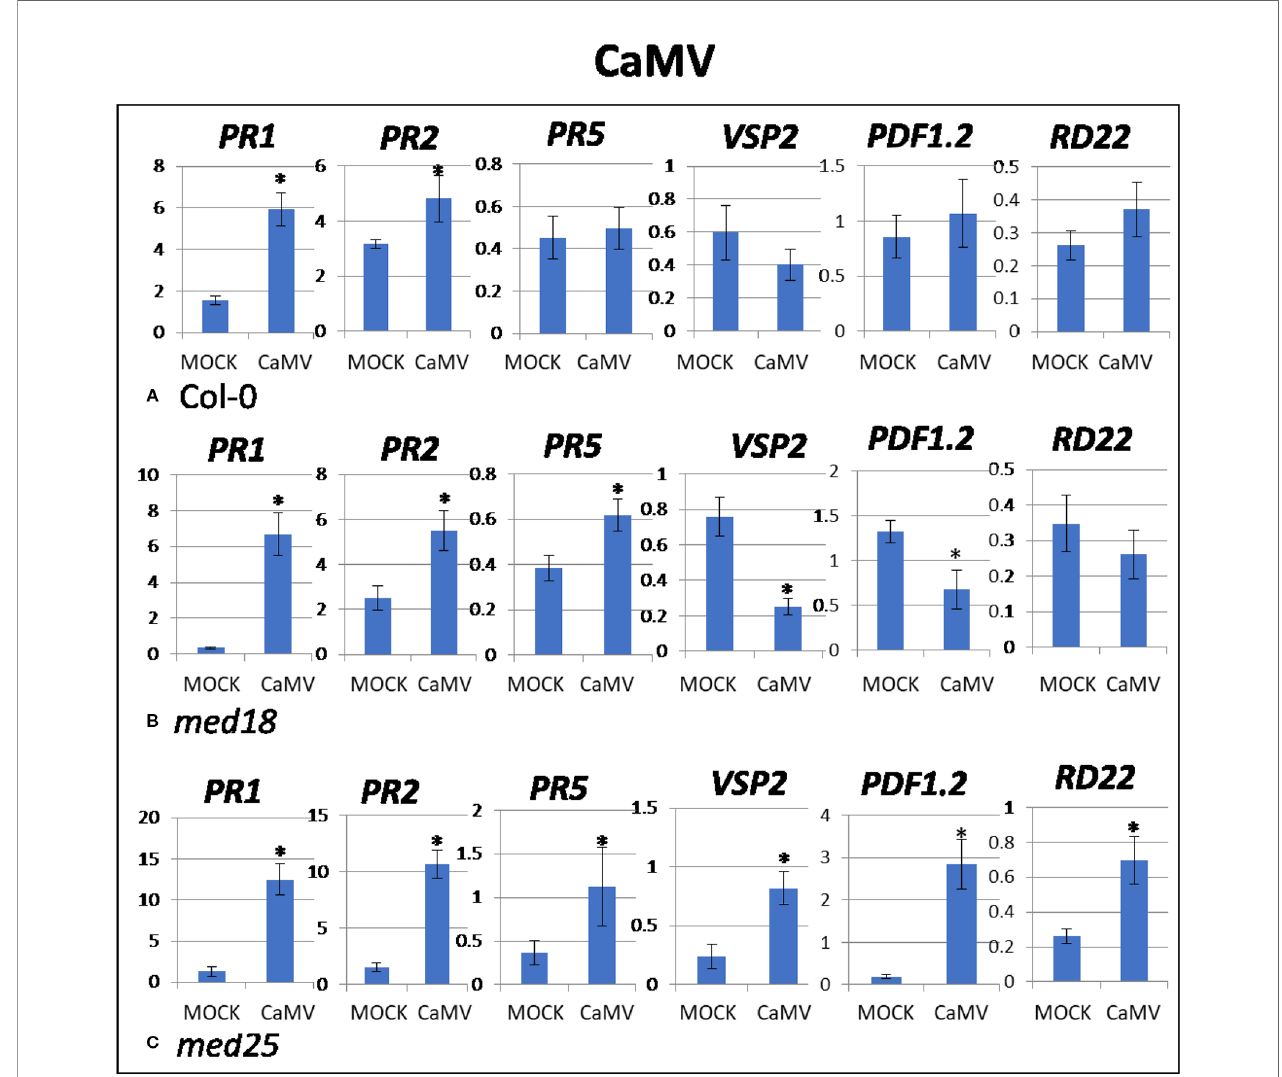
FIGURE 3 | Quantitative reverse transcriptase PCR (qRT-PCR) assays with SA- ( PR1, PR5 ), JA- ( PDF1.2, VSP2 ) and ABA- ( RD22 ) signaling marker genes of Arabidopsis plants inoculated with CaMV. Shown on the Y axes are mean ± SE values of transcript abundances relative to ACTIN housekeeping genes for (A) wild- type Col -0, (B) med18 , and (C) med25 plants at 2 days after inoculation. Asterisks indicate signi fi cant ( P < 0.05) induction or repression of each gene by comparing the means of mock-inoculated to CaMV-infected